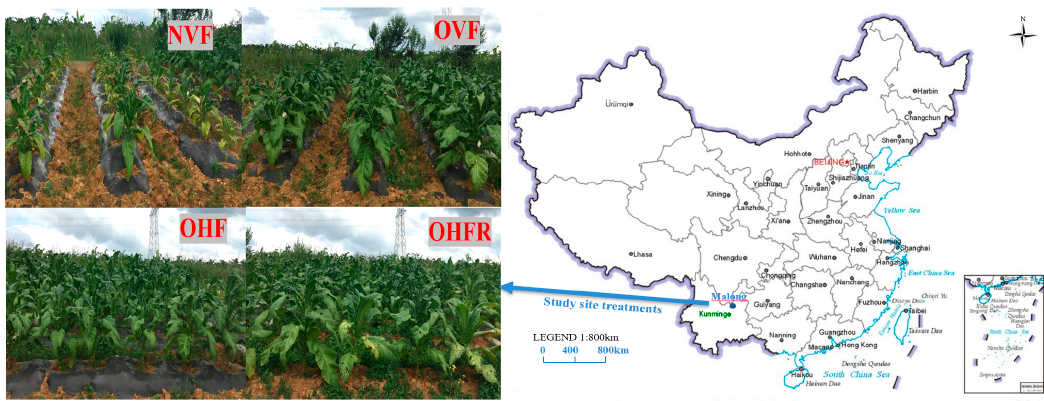
Figure 1. Photos and location of the long-term experiment plots for four treatments .